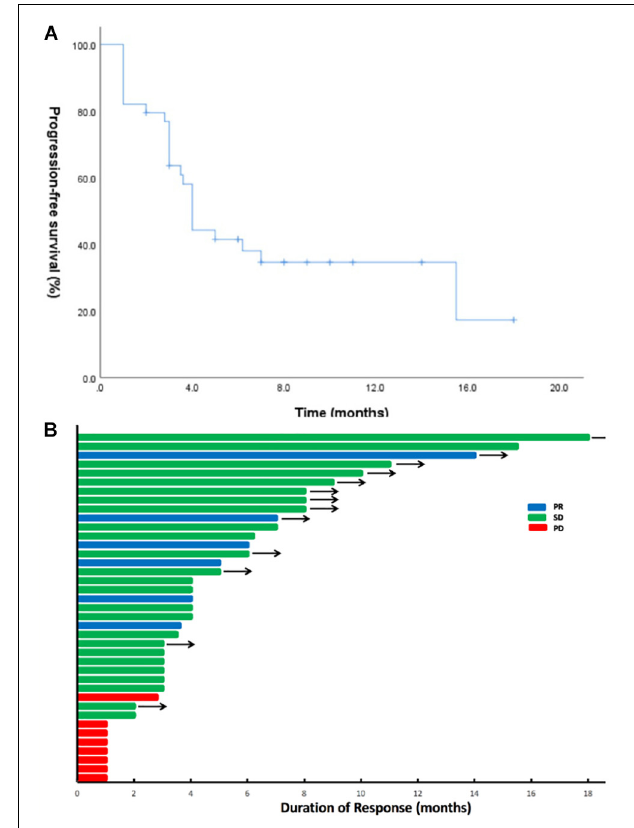
FIGURE 2 | Apatinib and osimertinib activity in osimertinib-resistant EGFR-mutant NSCLC. (A) Progression-free survival (PFS) in the 39 patients treated with the combination of apatinib and osimertinib. (B) Swimmer plots showing the duration of combination treatment for each patient in the study cohort. Patients who developed a progressive disease are denoted in red, stable disease in green, and partial response in blue. Arrows indicate patients continuing on the combination of apatinib and osimertinib at the time of last